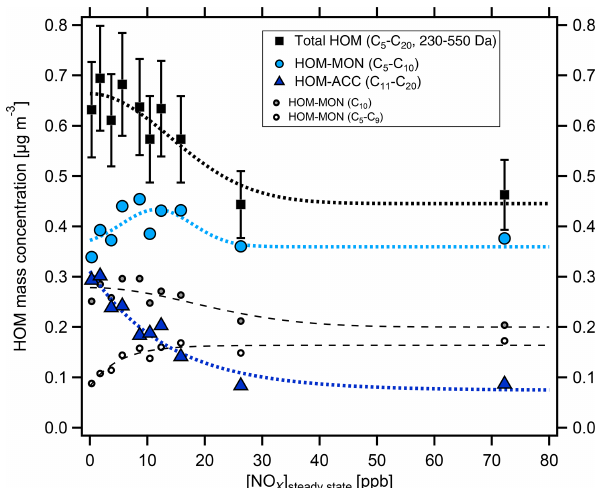
Figure 2. HOM spectra from photooxidation of α -pinene (a, c) and β -pinene (b, d) without NO x addition (a, b) and with NO x addition (c, d) . NO x concentrations in the α -pinene and β -pinene experiments were 26 and 38ppb, respectively. Background NO x was 0.3ppb. The signals were normalized to the sum over all detected ions. For the α -pinene example, in the low-NO x case HOM monomers contribute ≈ 0 . 4µgm − 3 and HOM-ACCs ≈ 0 . 3µgm − 3 , whereas at 26ppb NO x HOM monomers contribute ≈ 0 . 4µgm − 3 and HOM-ACCs less than 0.1µgm − 3 (compare Fig. 3).